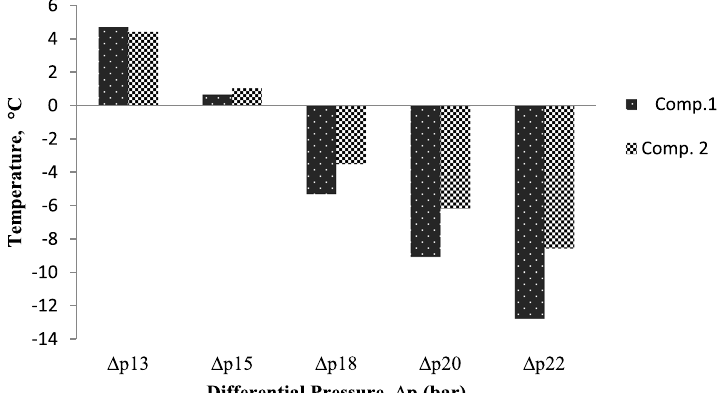
Table 3 Hydrocarbon dew point, water dew point, and cricondentherm using different compositions (C1 and C2) J–T valve differential pressure, (∆p), bar 15 15 Hydrocarbon dew point, °C Water Dew Point, °C Cricondentherm, °C 0.50